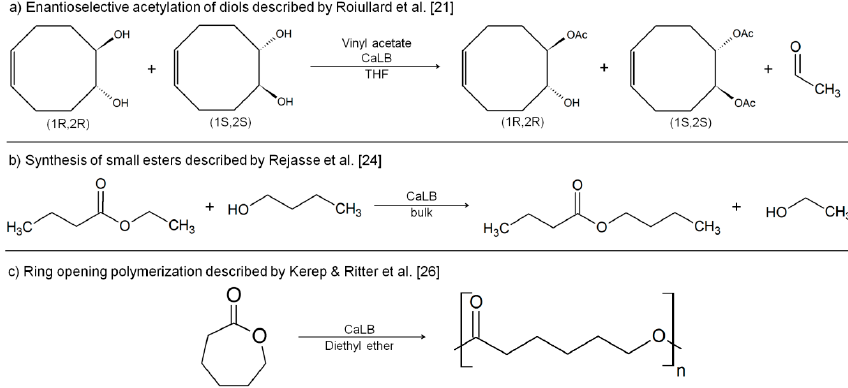
Figure 1. MWe-assisted CaLB-catalyzed reactions, already reported in the literature.